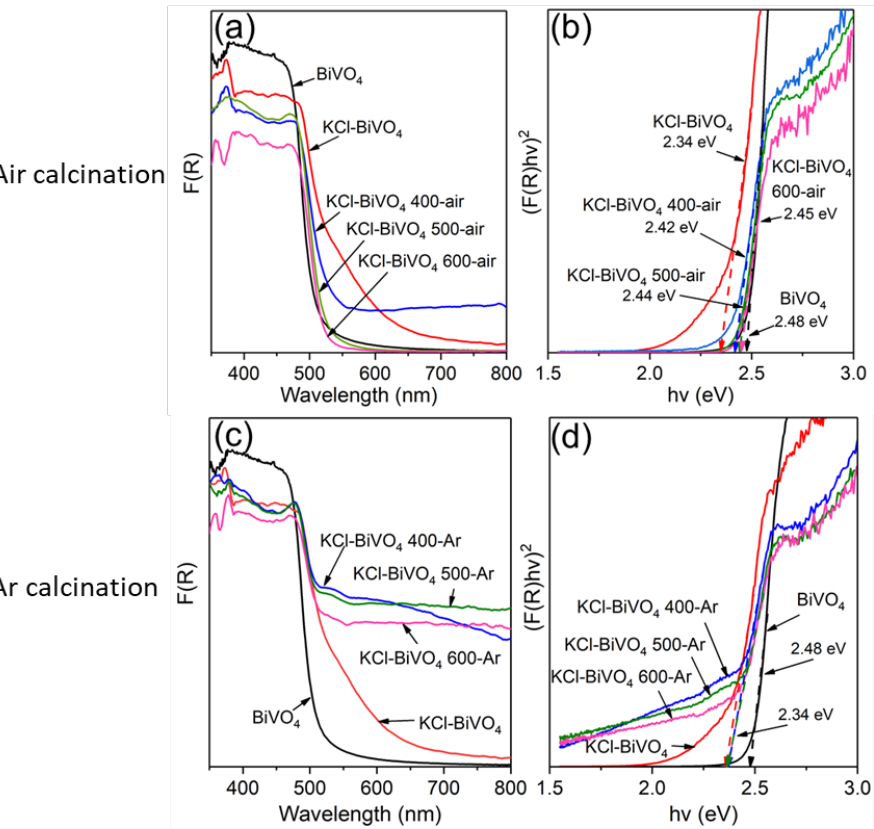
Figure 6. UV-vis absorption spectra (left) and Tauc plots [ (F(R)hv) 2 vs. hv ] (right) of pristine BiVO 4 , KCl-BiVO 4 and KCl-BiVO 4 calcined at different temperatures in ( a , b ) air and ( c , d ) Ar gas.